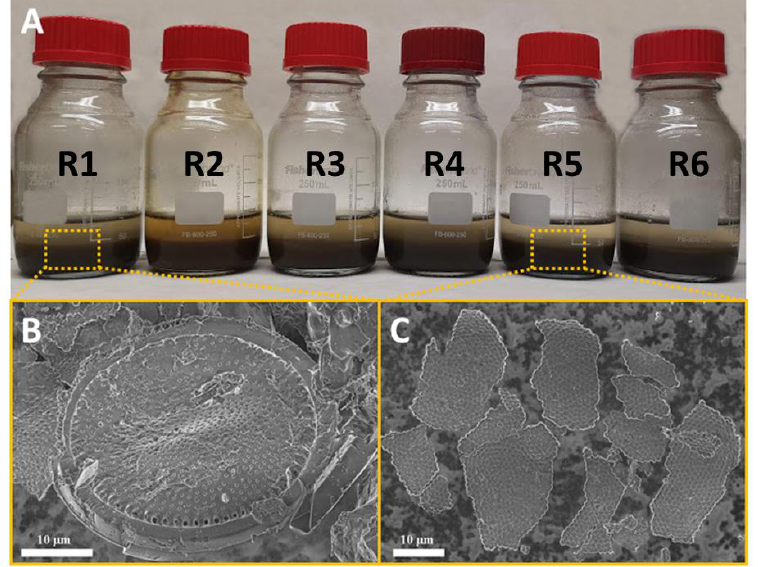
Figure 3. Reactors after disintegration and SEM analysis: ( A ) Reactors after disintegration. From left to right: R1: blank; R2: nZVI (0.2 g/L); R3: PDS (8.4 mM); R4: PDS (8.4 mM) + nZVI (0.2 g/L); R5: PDS (8.4 mM) + nZVI/Ag (0.2 g/L); R6: PDS (8.4 mM) + nZVI/Cu (0.2 g/L). ( B ) SEM observations of WAS in the blank reactor (R1). ( C ) SEM observations of WAS treated with nZVI/Ag (0.2 g/L) + PDS (8.4 mM) (R5).